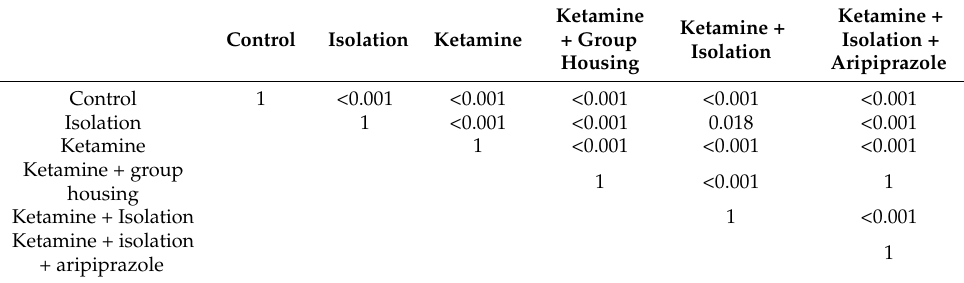
Table 9. All p -values following the post hoc comparison for the level of GPx in the